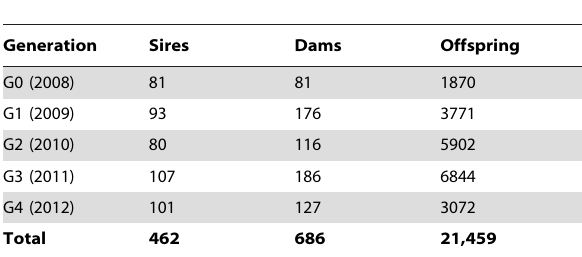
Table 1. Pedigree structure and number of offspring recorded over generations of selection.